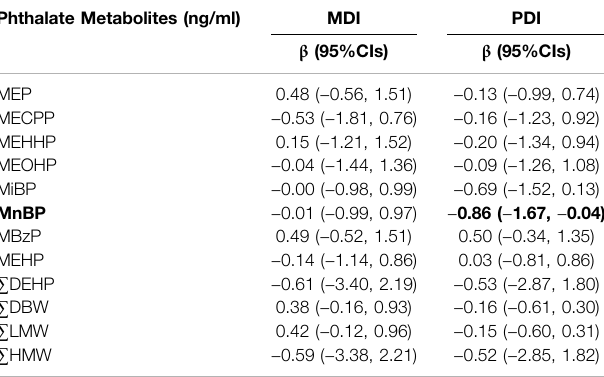
TABLE 3 | Associations between phthalate metabolite concentrations and neurocognitive